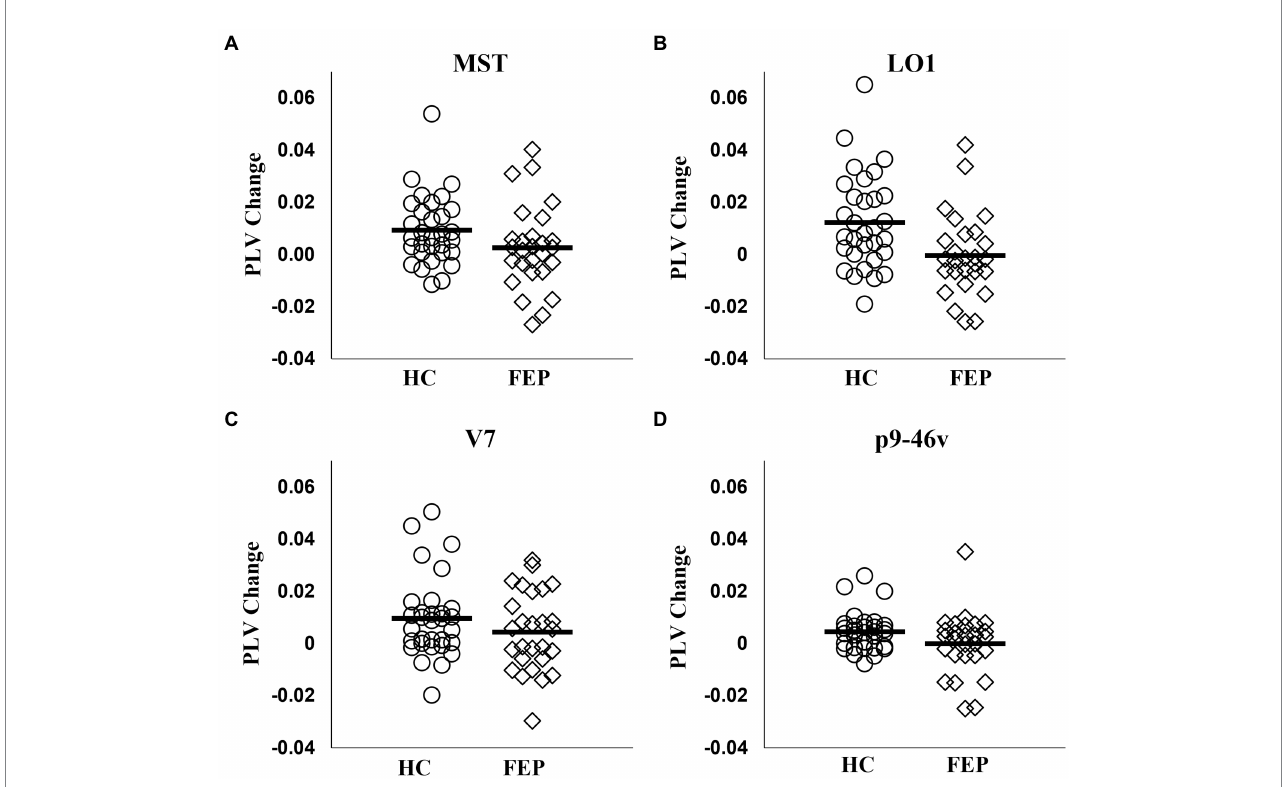
FIGURE 8 Right hemisphere network connectivity changes in HC and FEP. Similar to the left hemisphere network, there was a significant reduction in the modulation of theta band connectivity with attention (measured with change in phase-locking value) across regions in the right hemisphere network in FEP (A–D) .